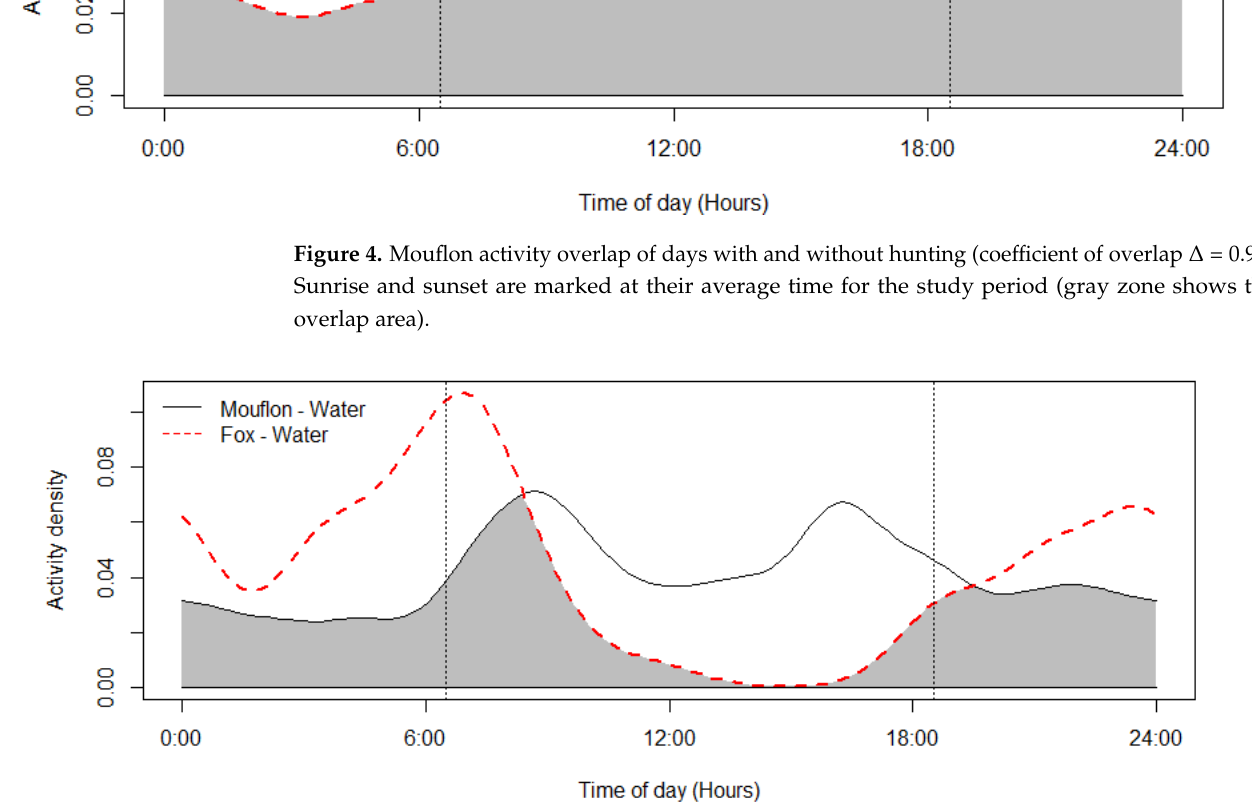
Figure 4. Mouflon activity overlap of days with and without hunting (coefficient of overlap Δ = 0.91). Sunrise and sunset are marked at their average time for the study period (gray zone shows the overlap area).